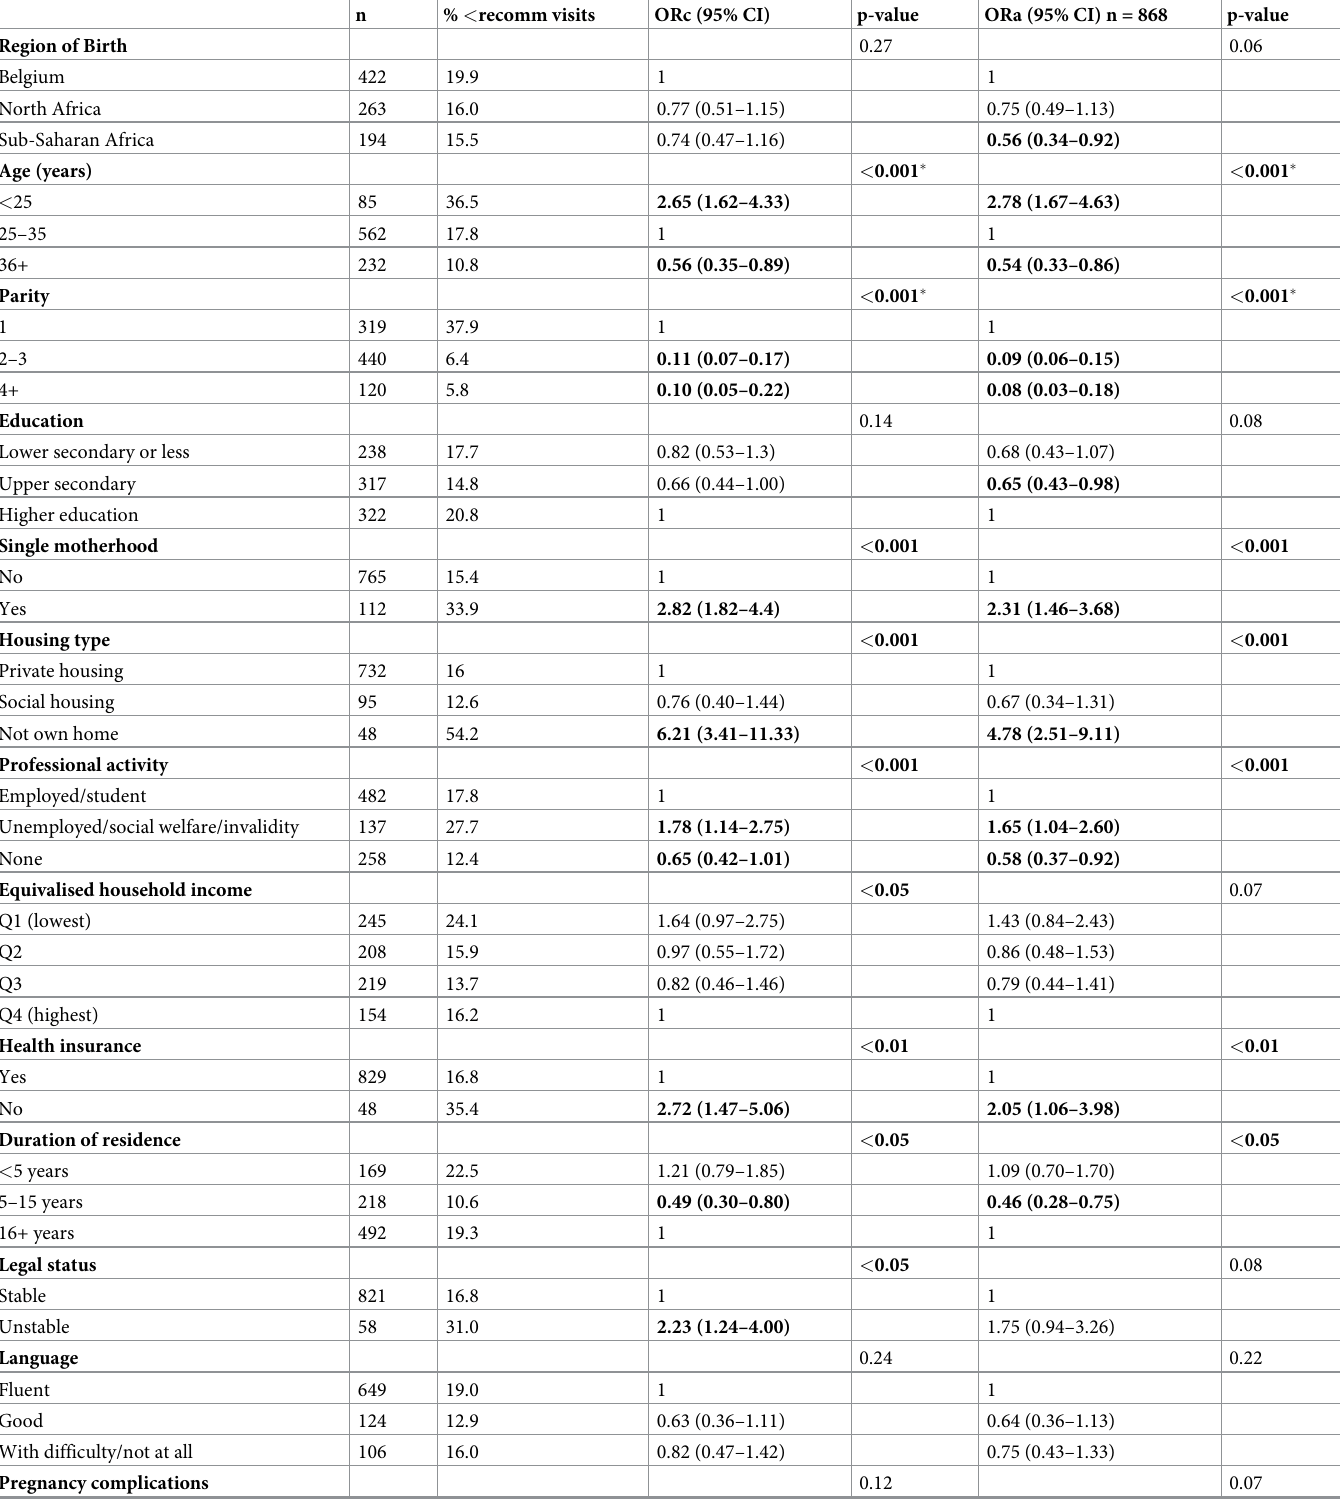
Table 5. Prevalence of less than recommended ANC visits, with crude and adjusted odds ratios and Wald X 2